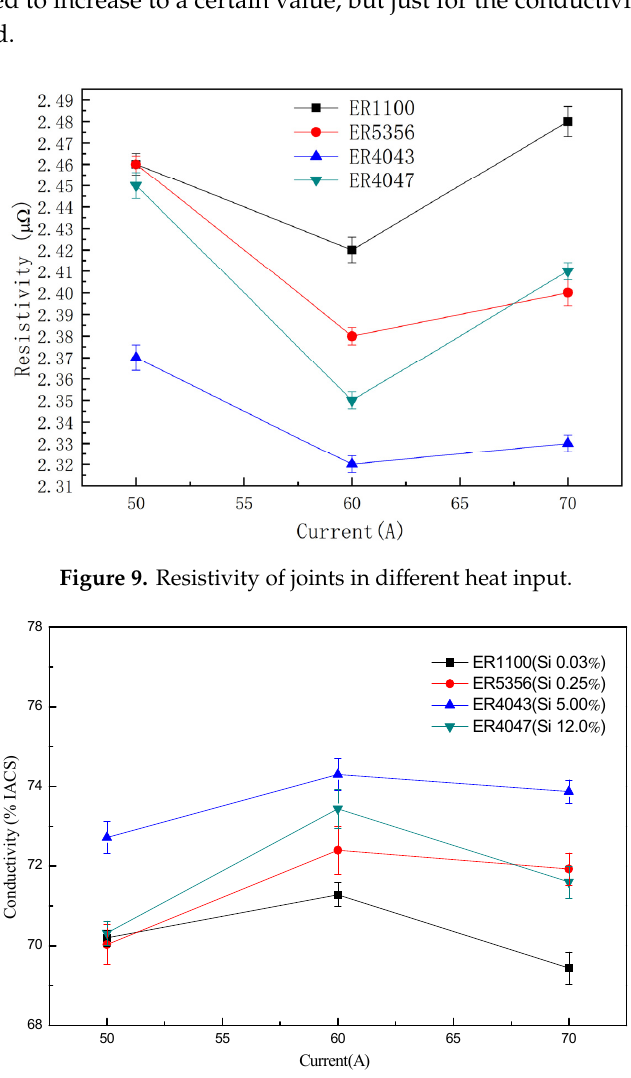
Figure 10. Conductivity of joints in different heat input.